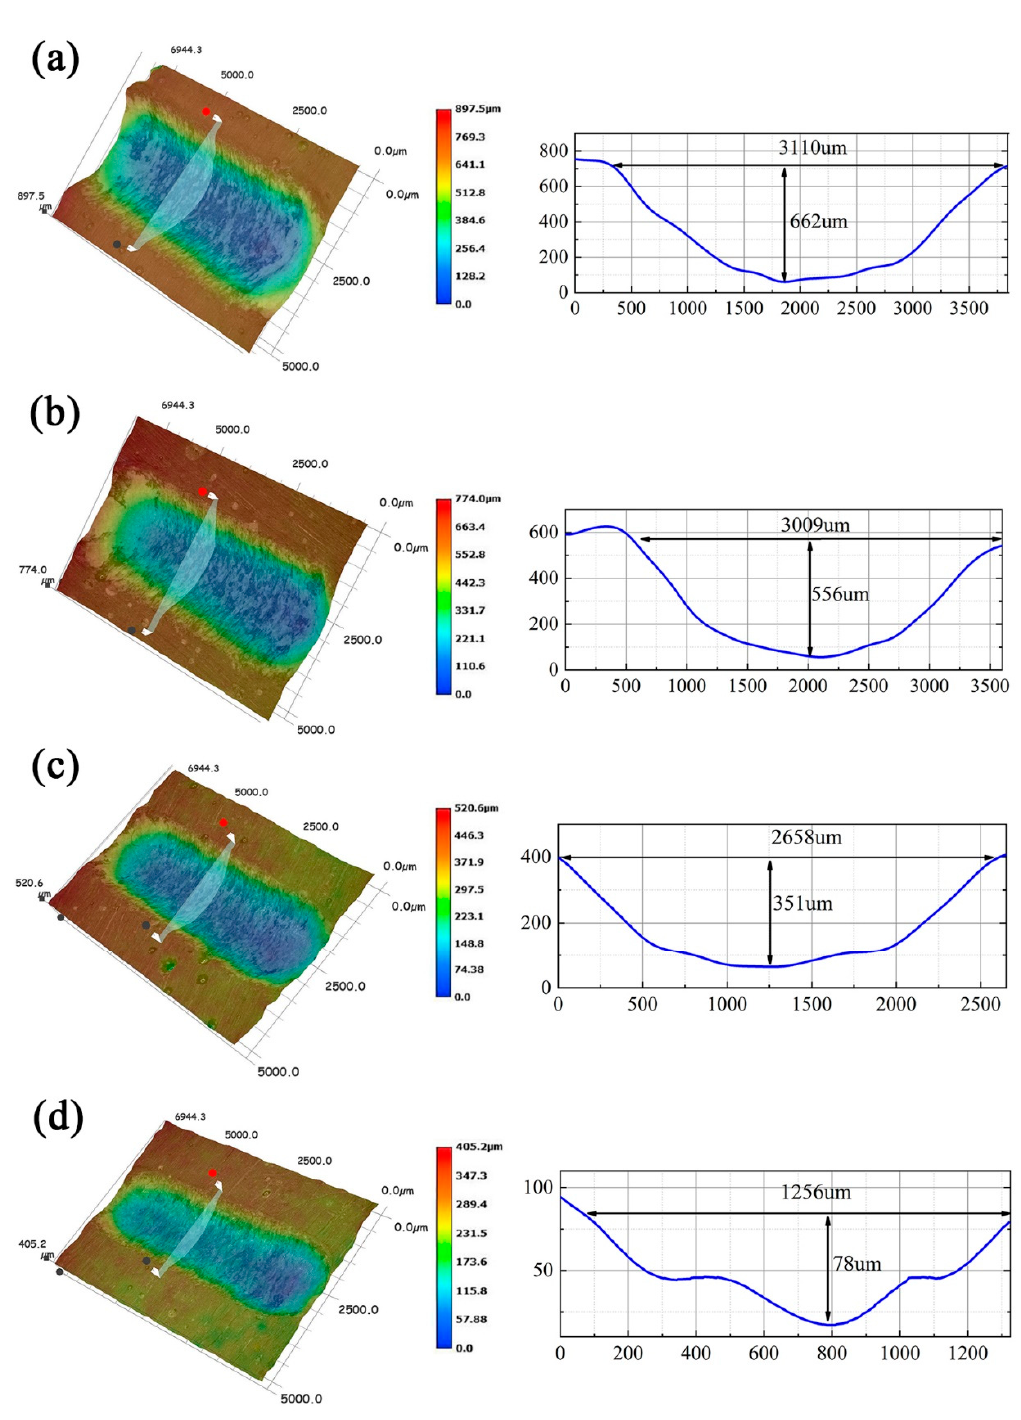
Figure 18. ( a – d ) The 3D morphologies and corresponding wear scar cross-sectional profiles of the four coatings: ( a ) EP coating, ( b ) SiC-G@GO 0.5 coating, ( c ) SiC-G@GO 1 coating, and ( d ) SiC-G@GO 2 coating.